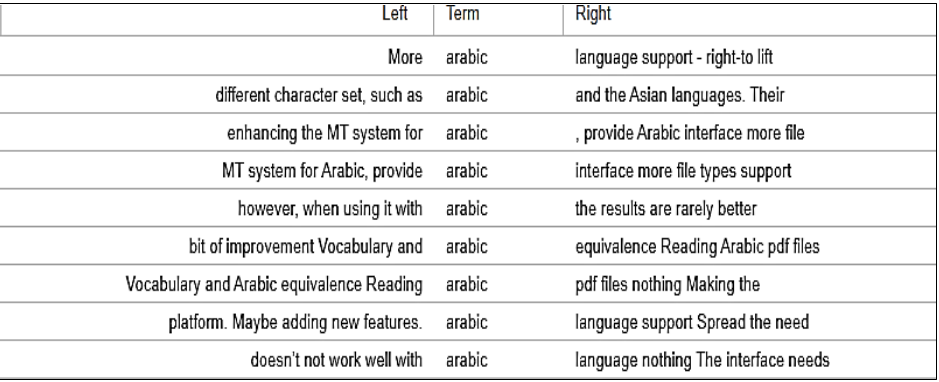
Figure 6. Concordance results for the most frequent word in suggested improvements to CAT.